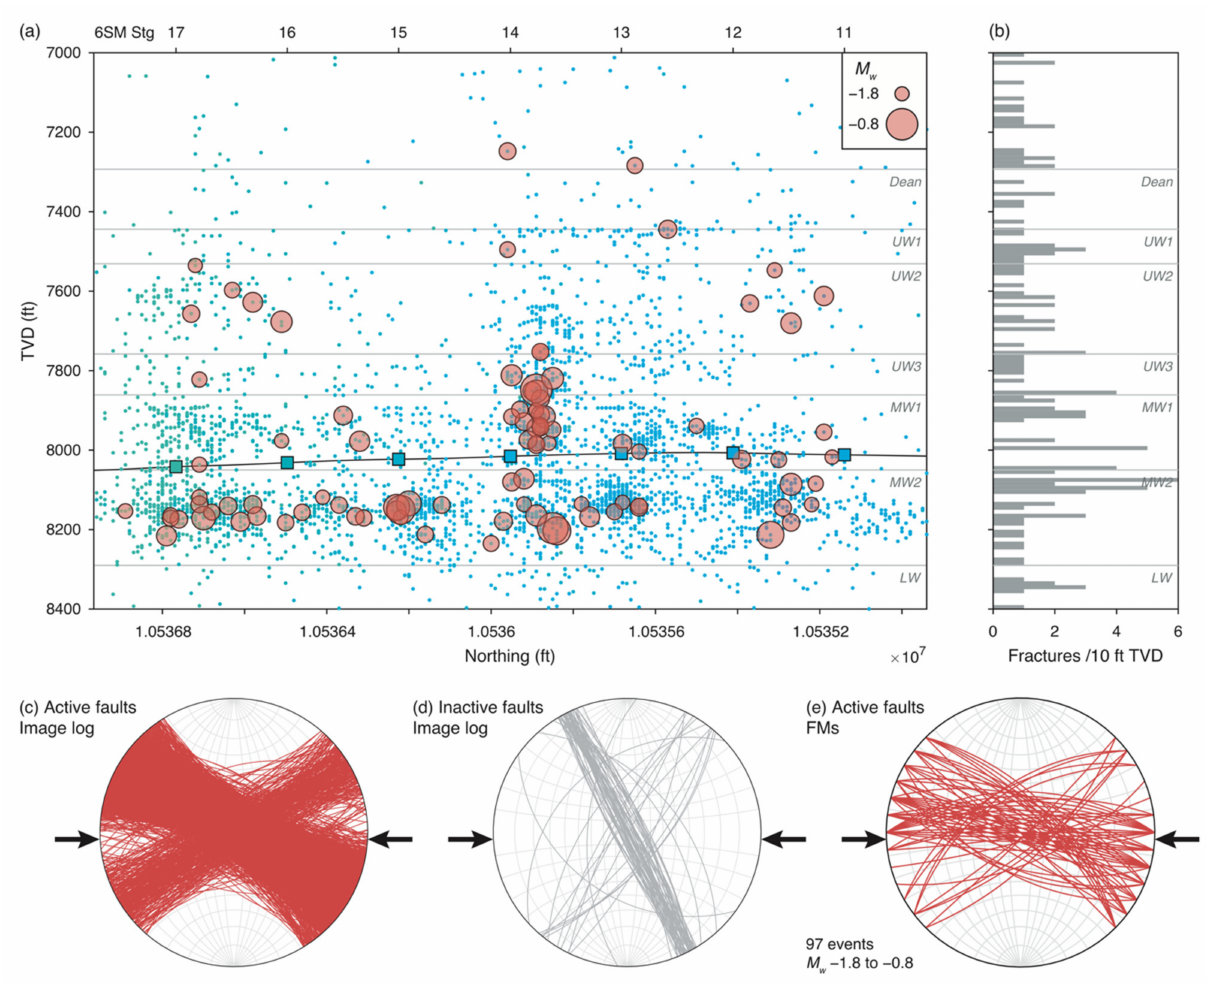
Figure 11. Earthquake focal mechanisms for well 6SM. ( a ) All microseismic events colored by stage (colored points). Events with moment tensor solutions in stages 11–17 sized by magnitude (red points). ( b ) Histogram of fractures observed in image logs in pilot well 7SU. ( c ) Stereonet of active fractures observed in image logs in horizontal wells 6SU and 6SM. Arrows indicate the direction of the maximum compressive stress, S Hmax . ( d ) Stereonet of inactive fractures. ( e ) Stereonet of primary nodal planes from the focal mechanism (FM)